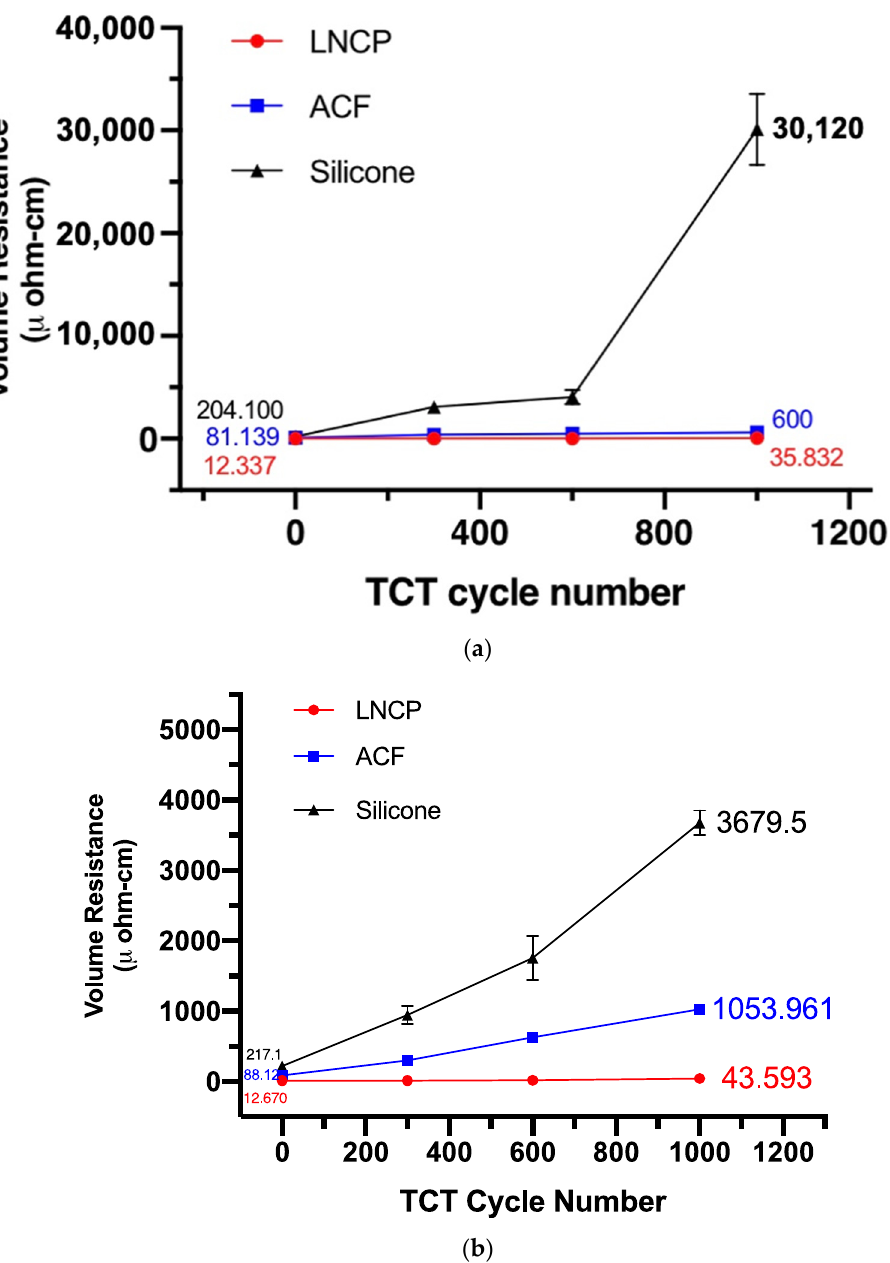
Figure 12. The relationship between the number of thermal cycles and respective electrical resistivity of the joints: ( a ) PI/Cu, and ( b ) PI/Cu/Ag (TCT: thermal cycling test).